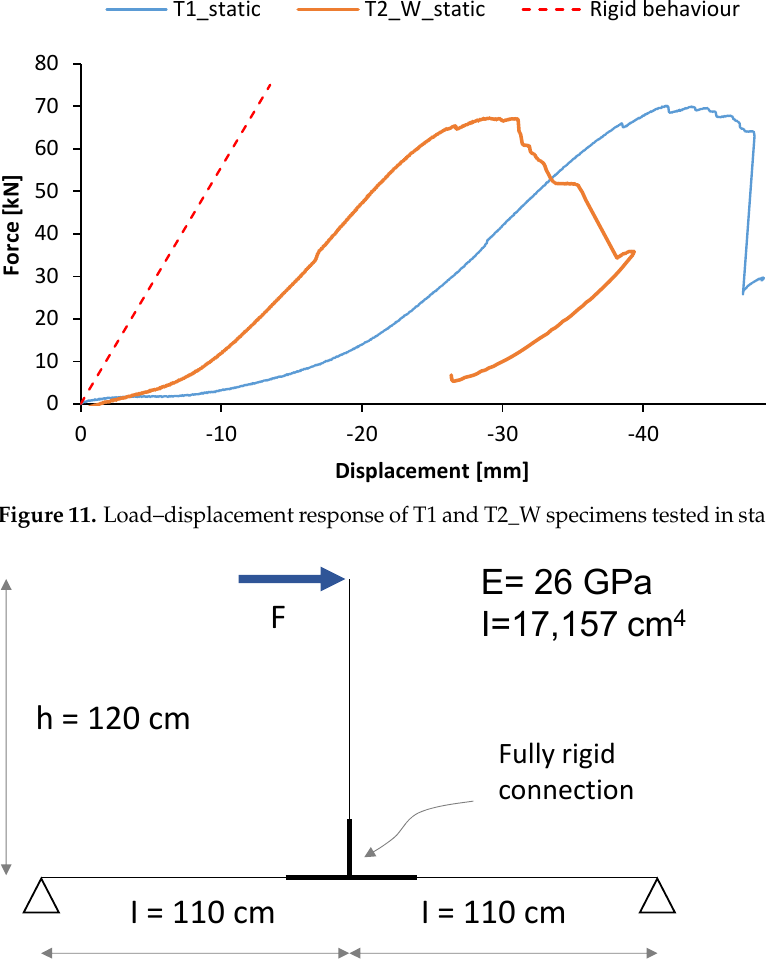
Figure 12. Structural scheme of the beam ‐ to ‐ column element adopted for the mechanical analysis.